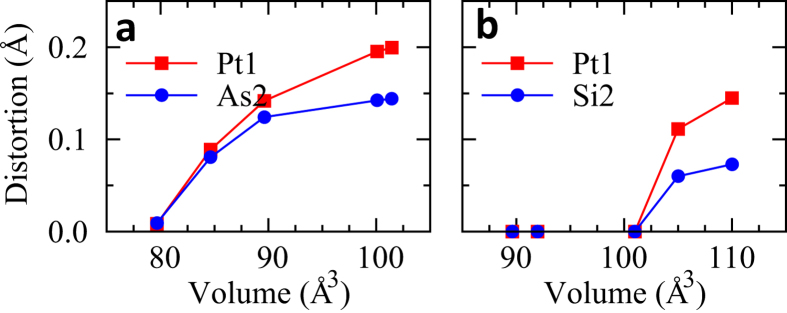
The variation of split distortion with the volume.(a) SrPt2As2 (b) LaPt2Si2. The experimental volumes are 100.08 Å3/f.u. for SrPt2As2 and 89.62 Å3/f.u. for LaPt2Si2.